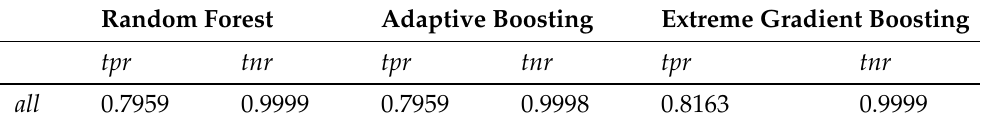
Table 12. Extended CreditCard dataset ensemble methods based fraud